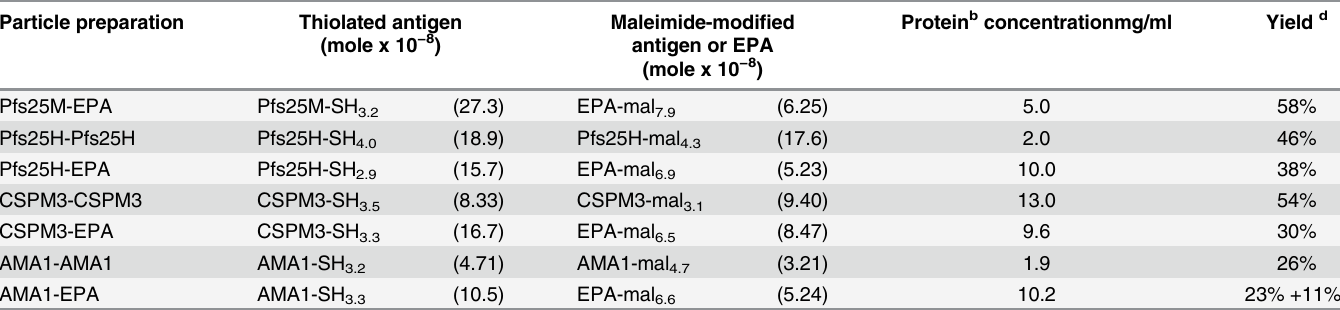
Table 3. Particle forming reaction parameters a